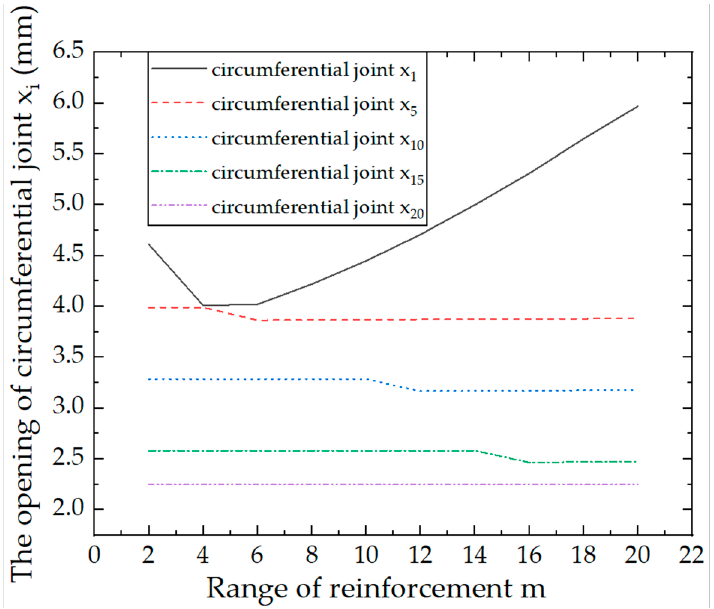
Figure 14. The relation curve between reinforcement range and the opening of circumferential joints for different rings.